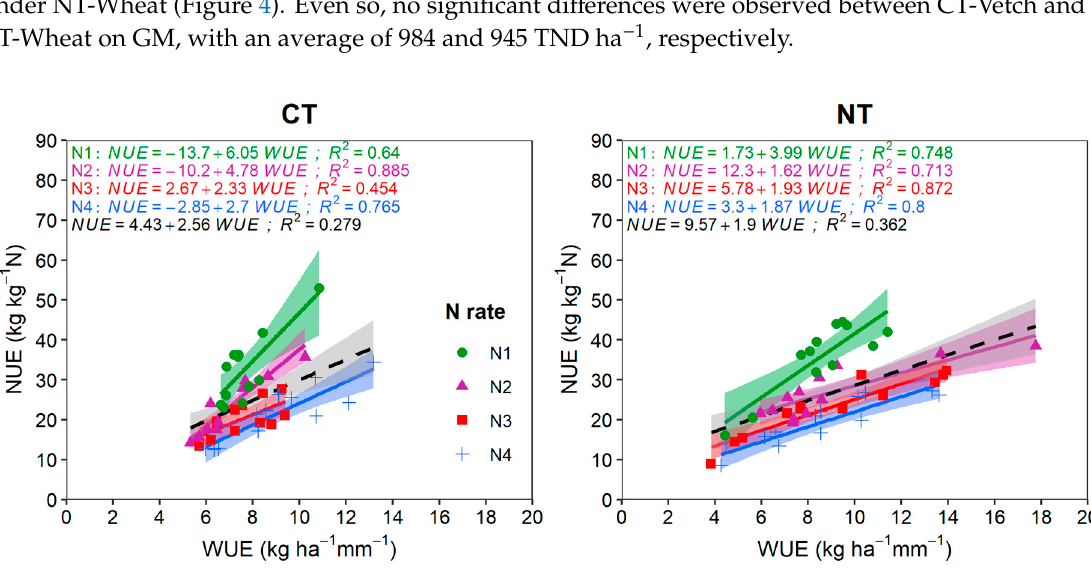
Figure 3. Simple linear regressions relating nitrogen use efficiency (NUE) to water-use efficiency (WUE) used at four N rates individually (solid lines), and for the pooled data (dashed black line) for each tillage practices (CT and NT). Nitrogen rates (N rate) are represented with different symbols (N1: green circle; N2: purple triangle; N3: red square; N4: blue plus).